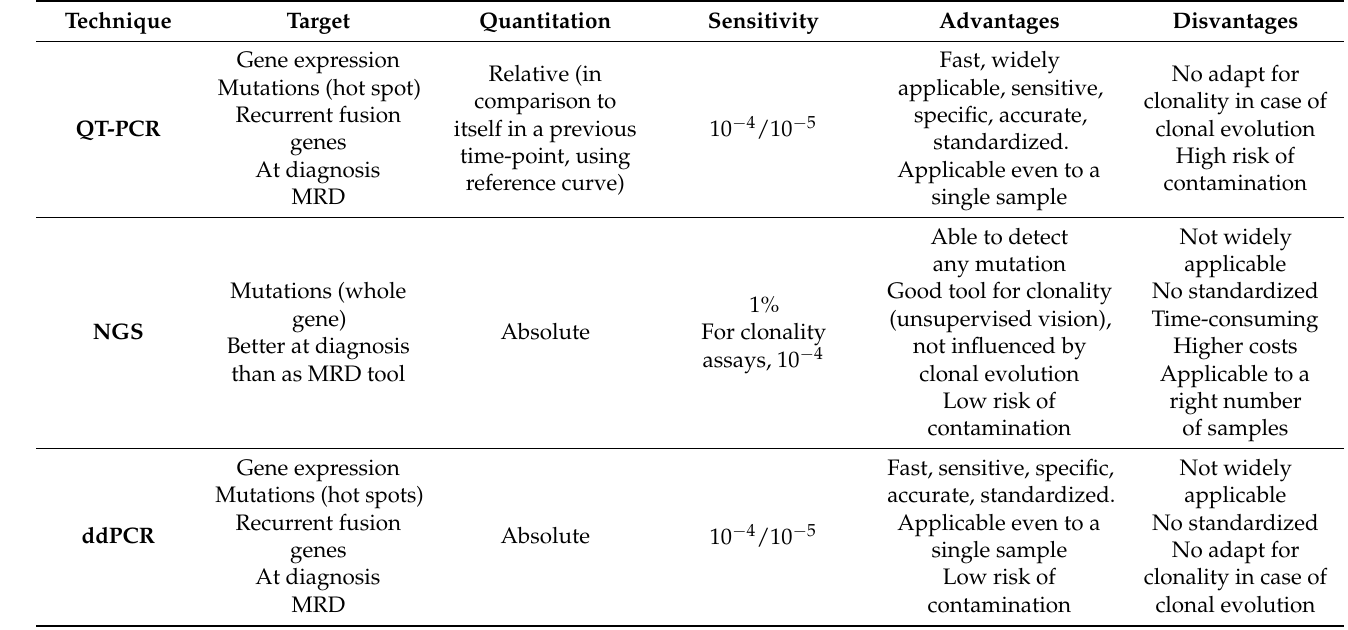
Table 4. Comparison among different quantitative molecular